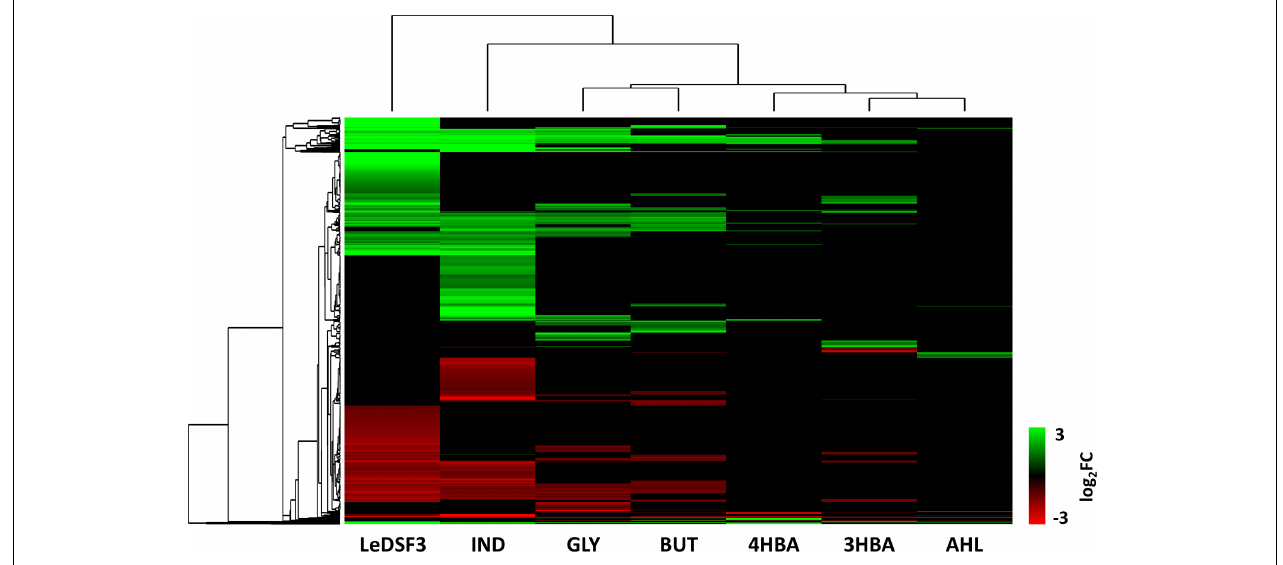
FIGURE 2 | Hierarchical clustering based on log2-fold change (FC) of Lysobacter capsici AZ78 genes differentially expressed (1,115 genes, Supplementary Tables 6–12 for gene expression data). LeDSF3, 13-methyltetradecanoic acid 50 µ M; IND, indole 500 µ M; GLY, glyoxylic acid 0.01 µ M; BUT, 2,3-butanedione 0.01 µ M; 3HBA, 3-hydroxybenzoic acid 30 µ M; 4HBA, 4-hydroxybenzoic acid 50 µ M; AHL, mix of N -acyl-homoserine lactones 20 µ